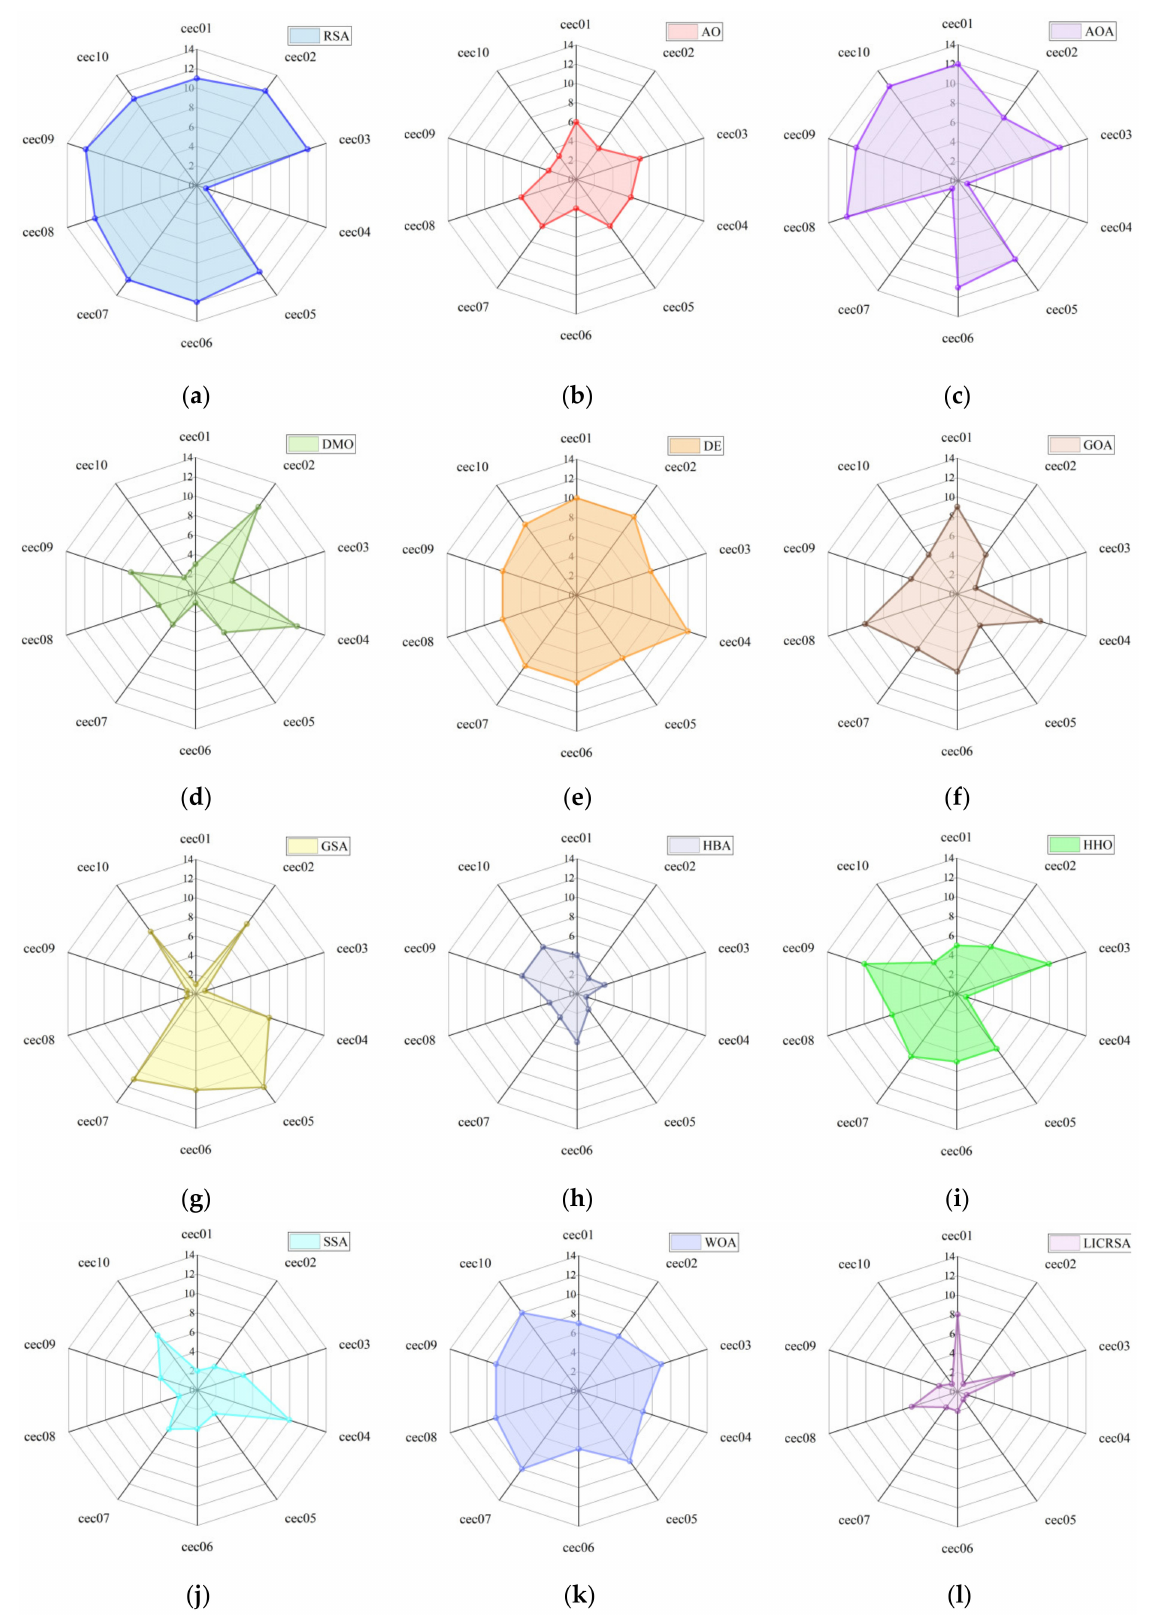
Figure 11. Radar plot of 12 algorithms in CEC2020: ( a ) RSA; ( b ) AO; ( c ) AOA; ( d ) DMO; ( e ) DE; ( f ) GOA; ( g ) GSA; ( h ) HBA; ( i ) HHO; ( j ) SSA; ( k ) WOA; ( l )